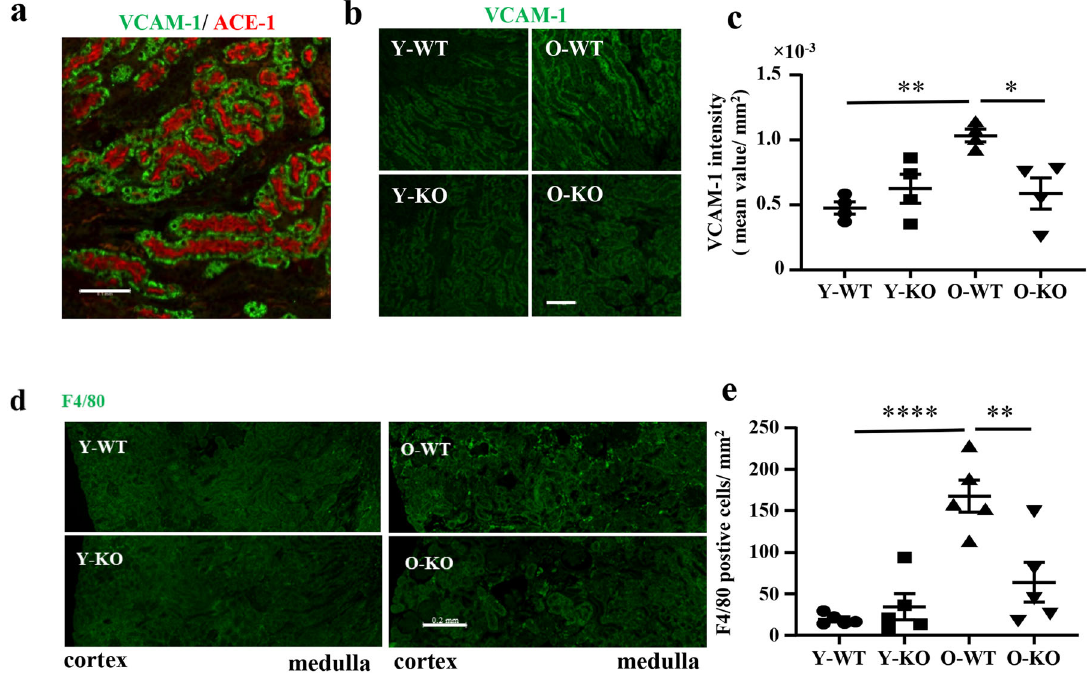
Fig. 5 Arg-II de fi ciency reduces age-associated VCAM-1 expression and macrophage accumulation in female mice. Central transverse renal sections (one section from each animal) were prepared from young and old WT and arg-II − / − female mice and subjected to immuno fl uorescence staining of a VCAM-1 and ACE-1 from an old WT female mouse (left panel), b VCAM-1 (right panel), n = 4; and d F4/ 80 ( n = 5). Representative images for ACE-1 and VCAM-1 were selected from outer medulla. Scale bars = 0.1 mm. The representative images for F4/80 contain cortex and medulla. Scale bars = ;0.2 mm. c , e Quanti fi cation of the intensity of fl uorescence signals from the whole renal section area was performed with LAS X software. * P ≤ 0.05, ** P ≤ 0.01, ****P ≤ 0.0001. Y-WT young WT, Y-KO young arg-II − / − , O-WT old WT, O- KO old arg-II − / −